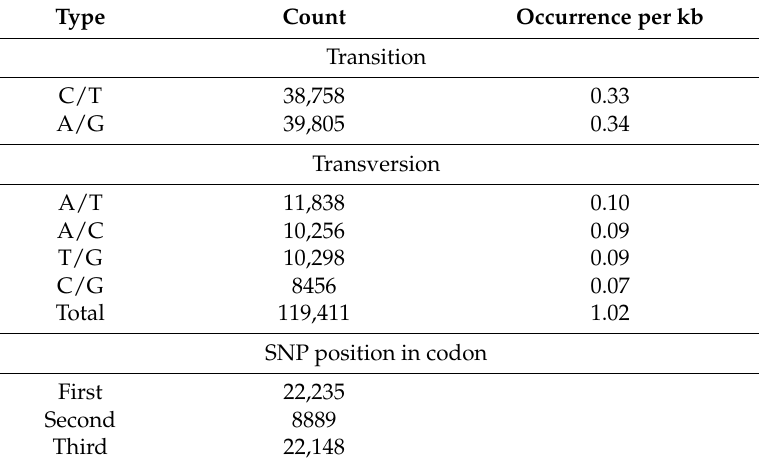
Table 4. Density and distribution of SNPs (single nucleotide polymorphisms) in Eucommia ulmoides genes derived from the assembled